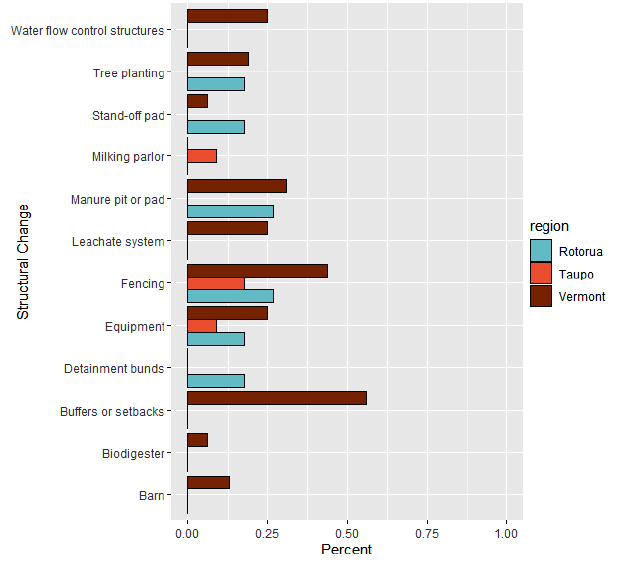
Fig. 3 . Percentage of sample reporting structural changes by